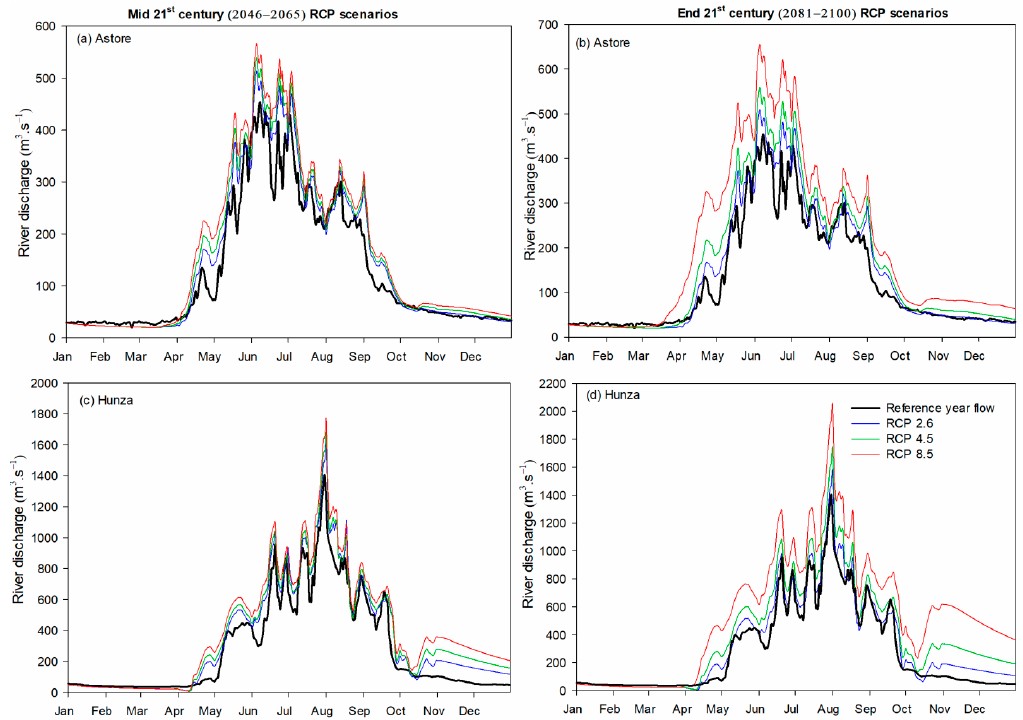
Figure 8. Predicted river flows from the Astore and Hunza basins under mid-21st (2046–2065) and late-21st (2081–2100) century RCP scenarios.